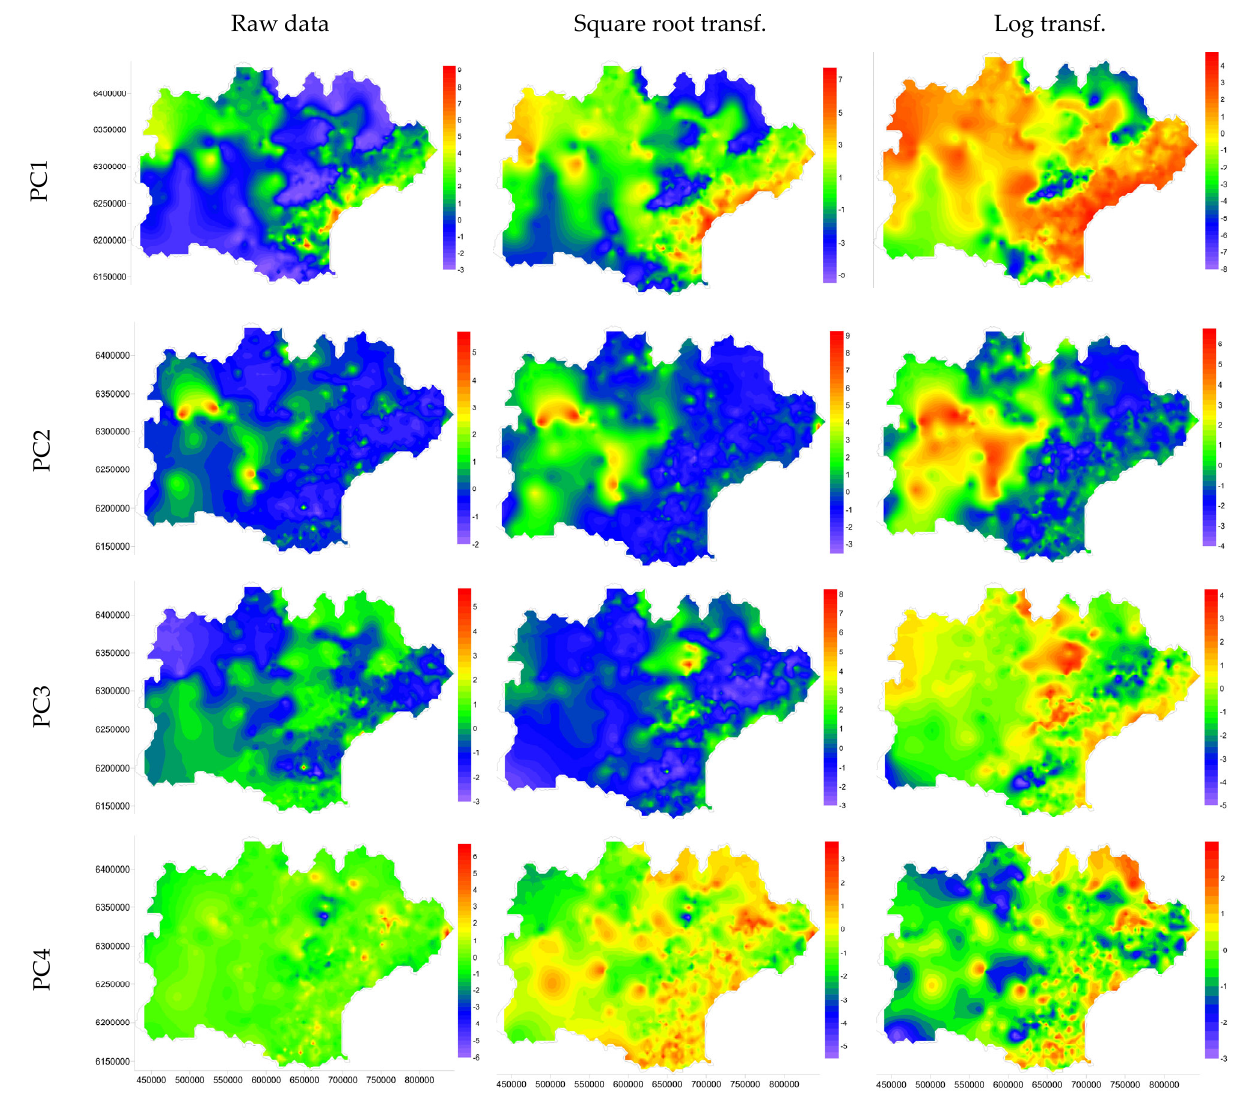
Figure 7. Distribution of the first four factorial axes over the Occitanie region using raw data, square